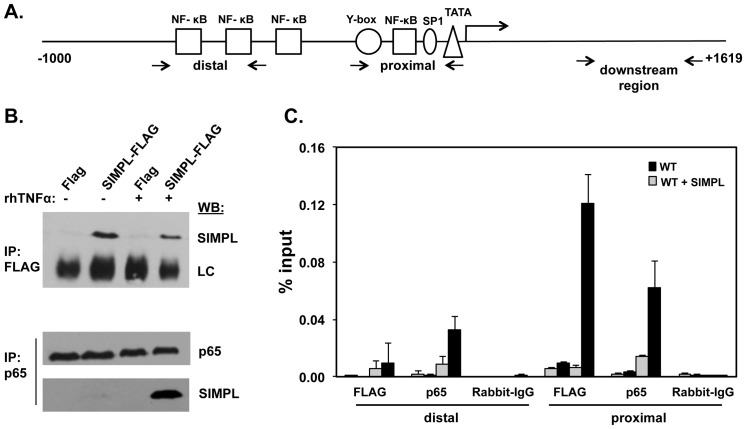
SIMPL is required for initiation of Tnf gene transcription.(A) Schematic of mouse Tnf gene annotated with the regions amplified by primers used to distinguish initiation (+24 to +121) and elongation (+1441 to +1537). (B) Total cellular RNA extracted from untreated and TNFα treated (rhTNFα 10 ng/ml, 45 min) MEFs derived from littermate control (WT) or SIMPL−/− mice was subject to quantitative RT-PCR with the indicated primers. Fold-change represents a ratio of TNFα treated to untreated sample of the same genotype. Assays were repeated at least three times and a 2-tailed T-test was used to determine statistical significance, **p<0.01.